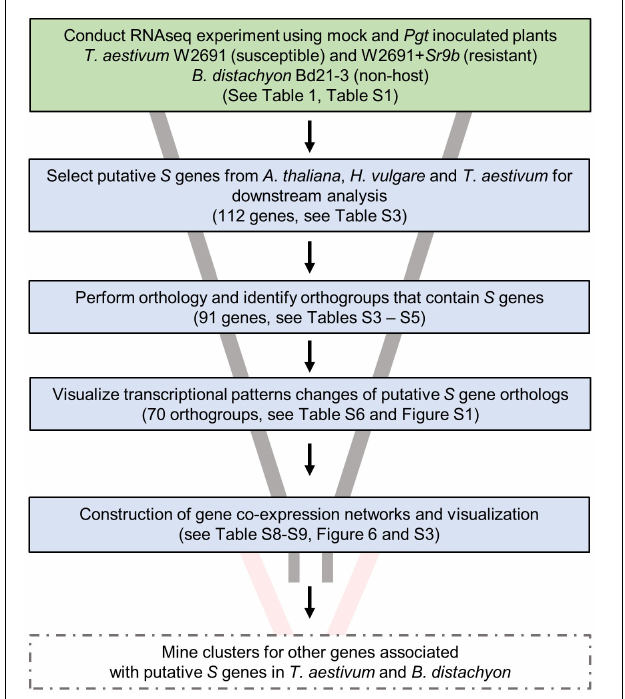
FIGURE 3 | Experimental workflow used to identify candidates of S genes that contribute to infection of T. aestivum by P. graminis f. sp. tritici. Solid box outlines indicate work completed in this publication. Future work is indicated by dashed box